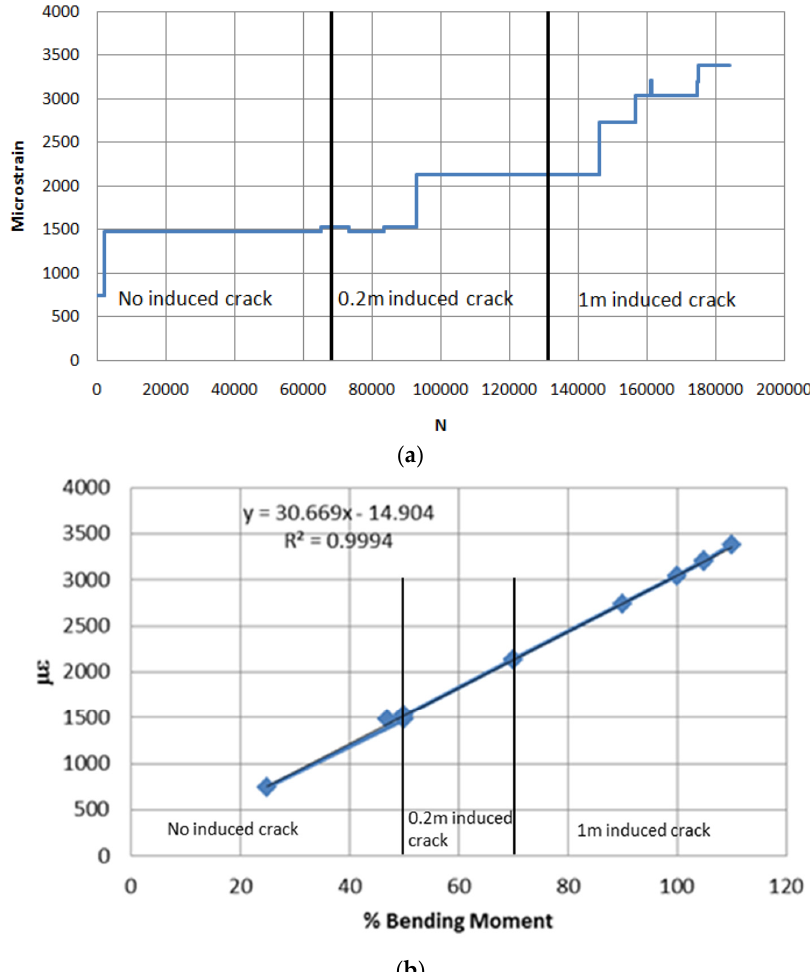
Figure 18. ( a ) SG2 reading versus number of cycles throughout fatigue testing and ( b ) Variation of SG2 strain versus BM loading throughout all three stages of fatigue